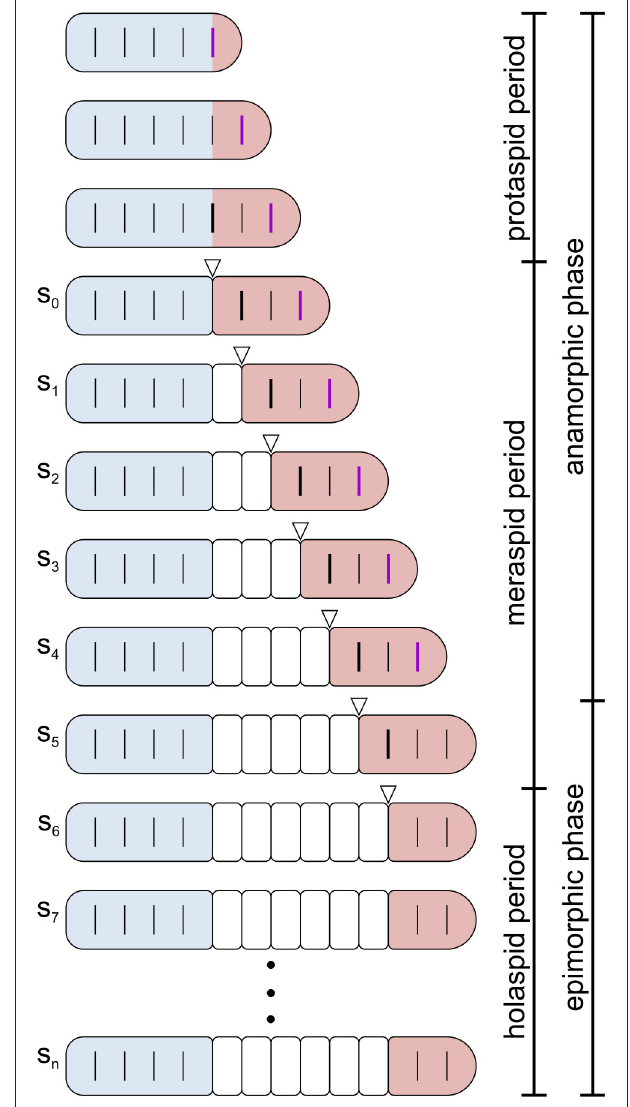
FIGURE 2 | Schematic representation of post-embryonic segmentation in a trilobite. Dorsal view. Increase in size is not represented and segmentation schedule and patterns do not correspond to any specific species ontogeny. Colors highlight the three main body regions in trilobites: cephalon, blue; thorax, white; pygidium, red. Transverse lines reaching the margins indicate articulated segmental boundaries, whereas incomplete transverse lines indicate segmental boundaries that are not functional articulations. A thick black incomplete segmental boundary in the pygidium indicates the place where a new articulation will emerge at the next molt, and a thick purple incomplete segmental boundary indicates the place where a new trunk segment will emerge at the next molt. Open arrowheads indicate the new articulation just developed. The bars on the right indicate the division of trilobite post-embryonic life into three periods (protaspid, meraspid, and holaspid periods, see text) and into two phases (anamorphic and epimorphic phases of the hemianamorphic development, see text). In the specific case depicted, the onset of the epimorphic phase (termination of trunk segment addition) preceded the onset of the holaspid period (termination of thoracic segment release). However, this was not the case for all trilobite taxa, and not for Aulacopleura koninckii , where the onset of the epimorphic phase coincided with the onset of the holaspid period. Post-protaspid stages are labeled s 0 –s n